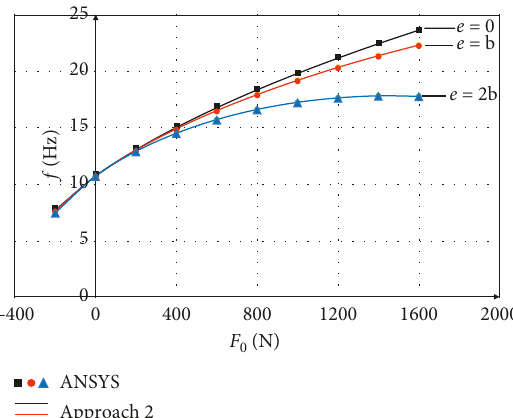
0 and e in accordance with equation (29).